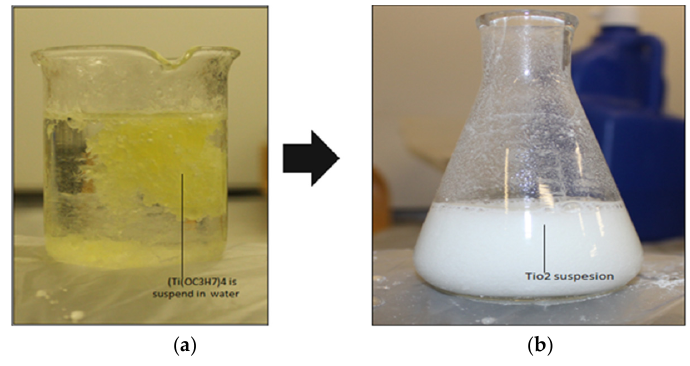
Figure 1. Creation of the titanium hydroxide suspension. ( a ) Before hydrolysis; ( b ) After hydrolysis.